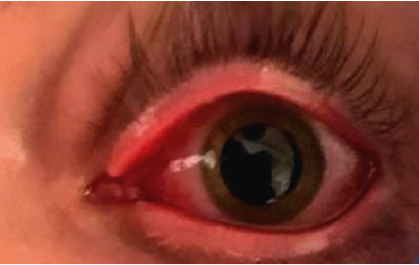
Figure 4: Left eye redness.